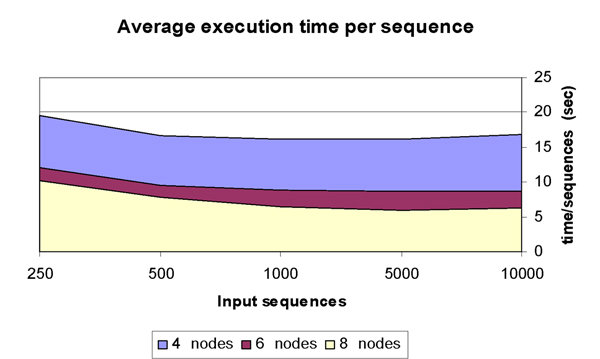
Average execution time per sequence. Data are reported to compare the average execution time per sequence in datasets of different dimension using a different number of working nodes. Time is reported in seconds.